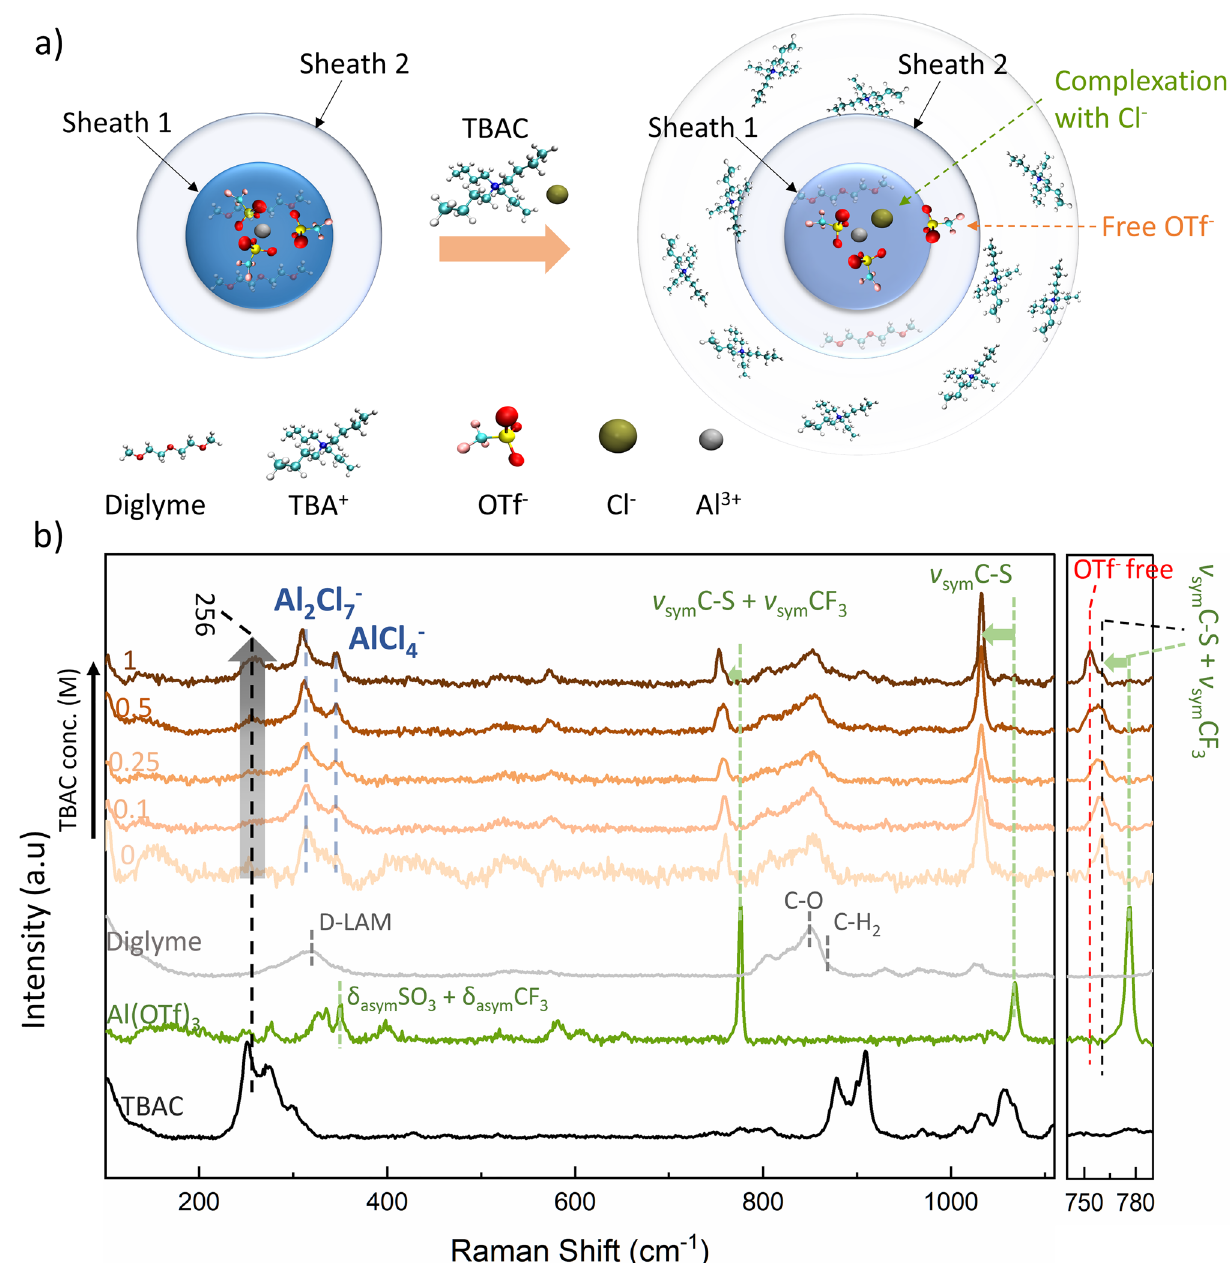
Fig. 4 a Schematic illustration of the solvation sheath evolution around Al-ion upon TBAC addition into Al(OTf) 3 -diglyme electrolyte (The number of molecules per Al-ion has been rounded off to the closest whole number co-ordination obtained from MD calculations in Figs. 3d–f and S6c). b Raman spectra obtained for TBAC, Al(OTf) 3 , diglyme and varying concentrations of TBAC in 0.5 M Al(OTf) 3 dissolved in diglyme (orange